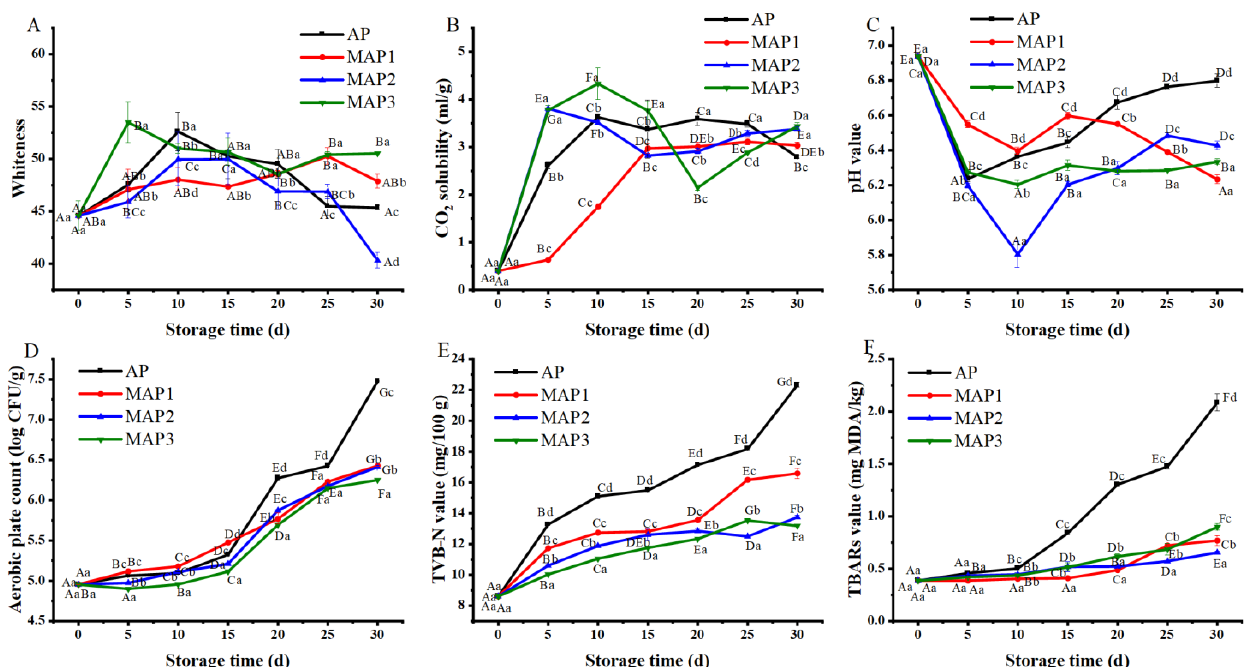
Figure 3. Effect of different gas components packaging on whiteness ( A ), CO 2 solubility ( B ) and pH value ( C ), APC ( D ), TVB-N value ( E ) and TBARs value ( F ) of golden pompano fillets during storage (−3 °C). Packaging system: AP (control group), MAP1 (30% CO 2 /70% N 2 ), MAP2 (50% CO 2 /50% N 2 ), MAP3 (70% CO 2 /30% N 2 ). Bars indicate the standard error. Different uppercase letters (A – G) indicate significant difference ( p < 0.05) in means (n = 3) between display times within the same packaging system; different lowercase letters (a – d) indicate significant difference ( p < 0.05) of means (n = 3) between packaging systems on the same day.